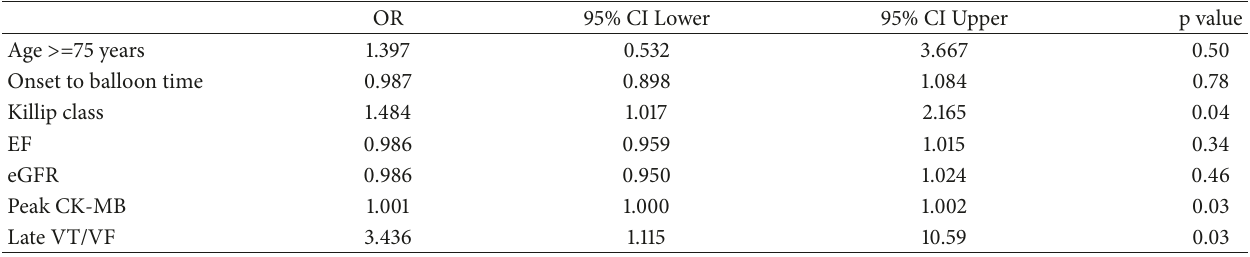
Table 5: The independent predictors for in-hospital cardiac death-Cox regression